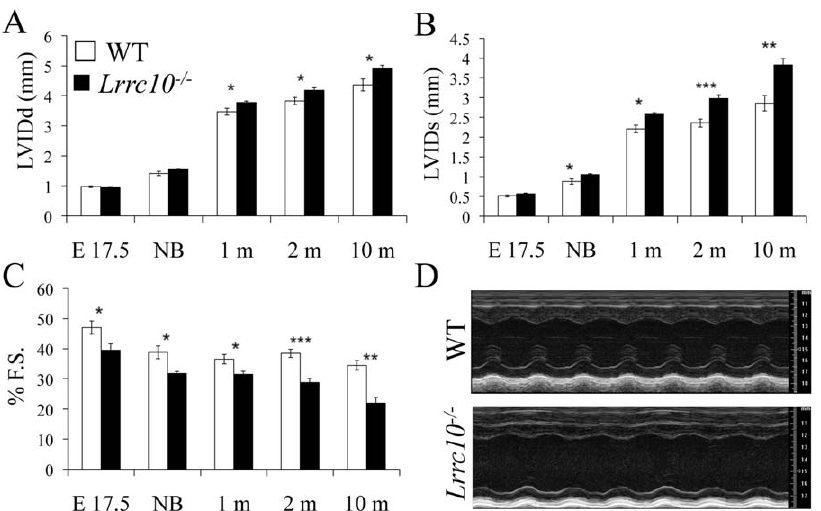
Figure 1. Lrrc10 2 / 2 mice develop dilated cardiomyopathy. Echocardiography reveals cardiac functional deficits in Lrrc10 2 / 2 mice. Left ventricular inner diameter (LVID) measurements during (A) diastole and (B) systole and (C) fractional shortening (F.S.) in WT and Lrrc10 2 / 2 mice at the indicated age. (D) Representative M-mode images at 10 months of age. E , embryonic day; NB , newborn; m , months; d , diastole; s , systole. n=4–13.